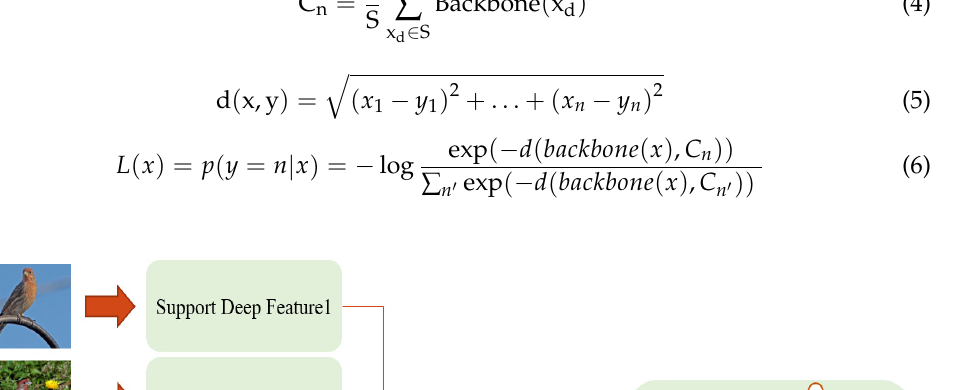
Figure 11. Support set deep feature extraction process.